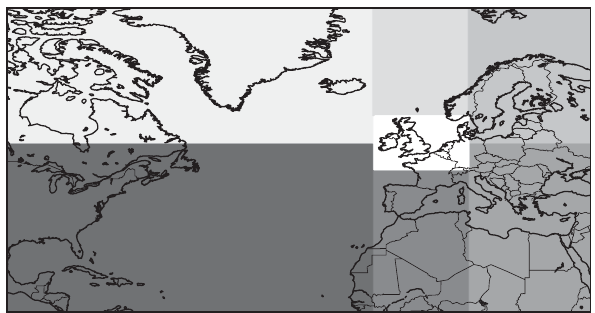
Figure 6. Schematic of the arrangement of the full NAME compu- tational domain, divided into six fixed regions and the sub-domain in which the transdimensional inference was performed, shown by the different shadings.